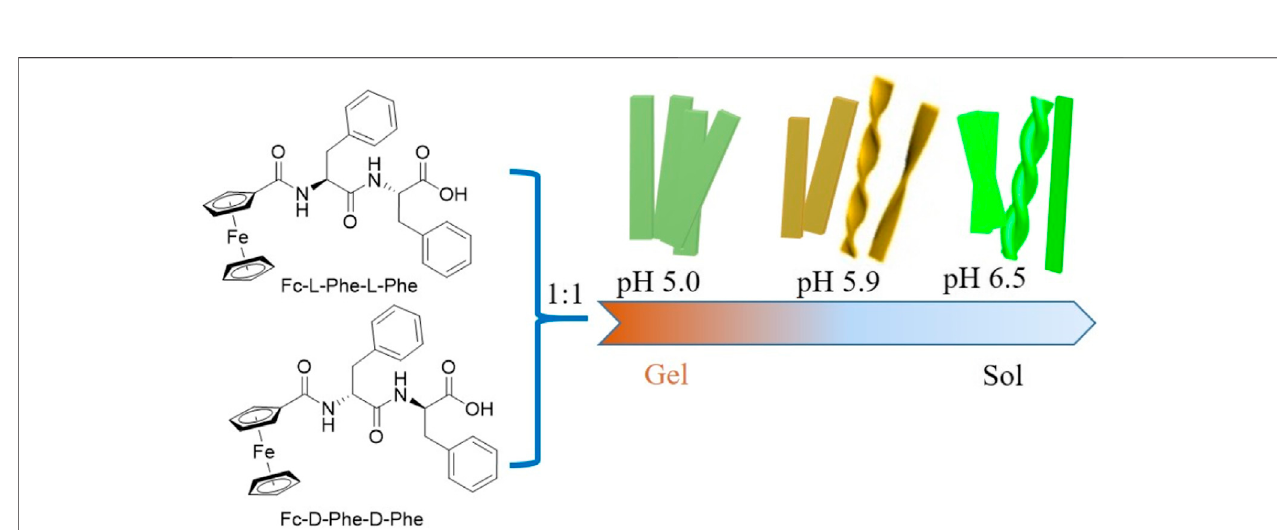
FIGURE 5 | The molecular structure of the Fc-L-Phe-L-Phe-OH and Fc-L-Phe-L-Phe-OH; the illustration of the pH responsiveness of the hydrogel (Zhang et al., 2020).